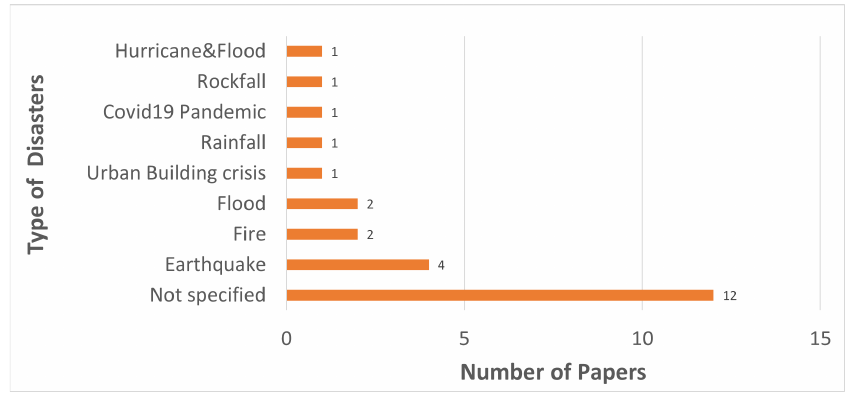
Figure 6. Disaster Types Targeted in the Reviewed